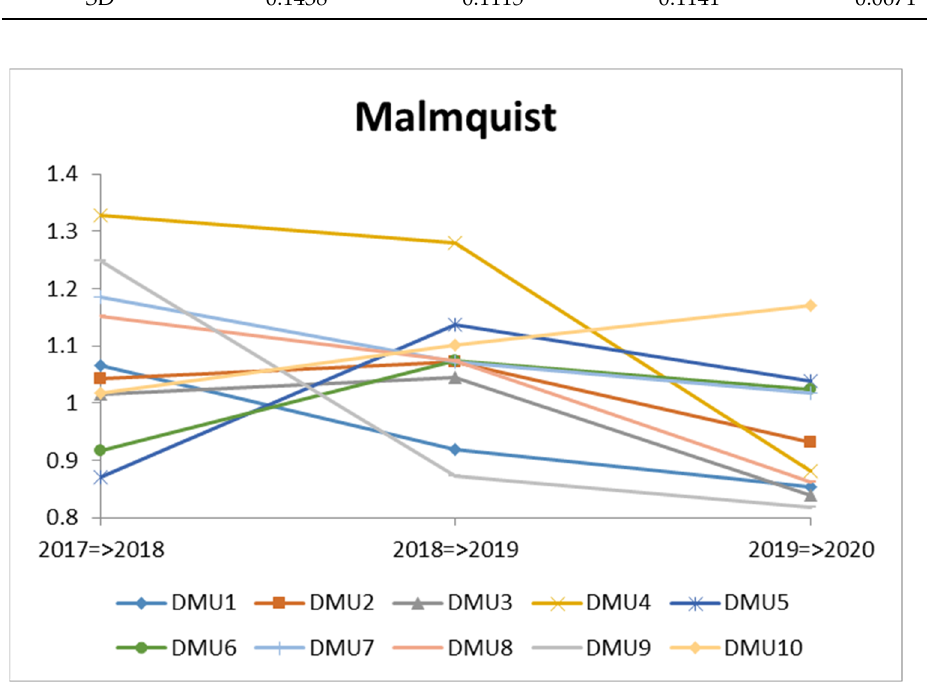
Figure 7. The Malmquist productivity index of DMUs